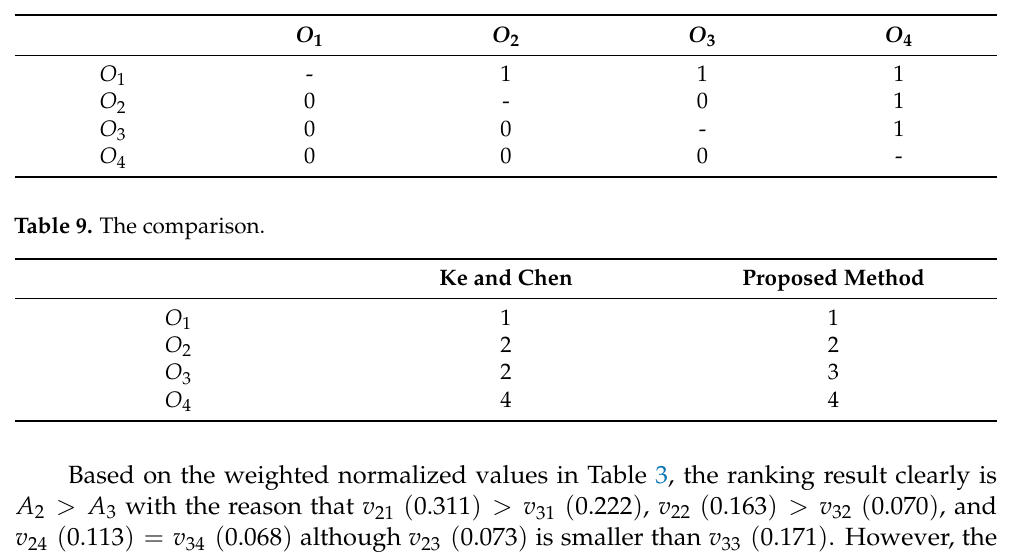
Table 8. The superiority matrix.